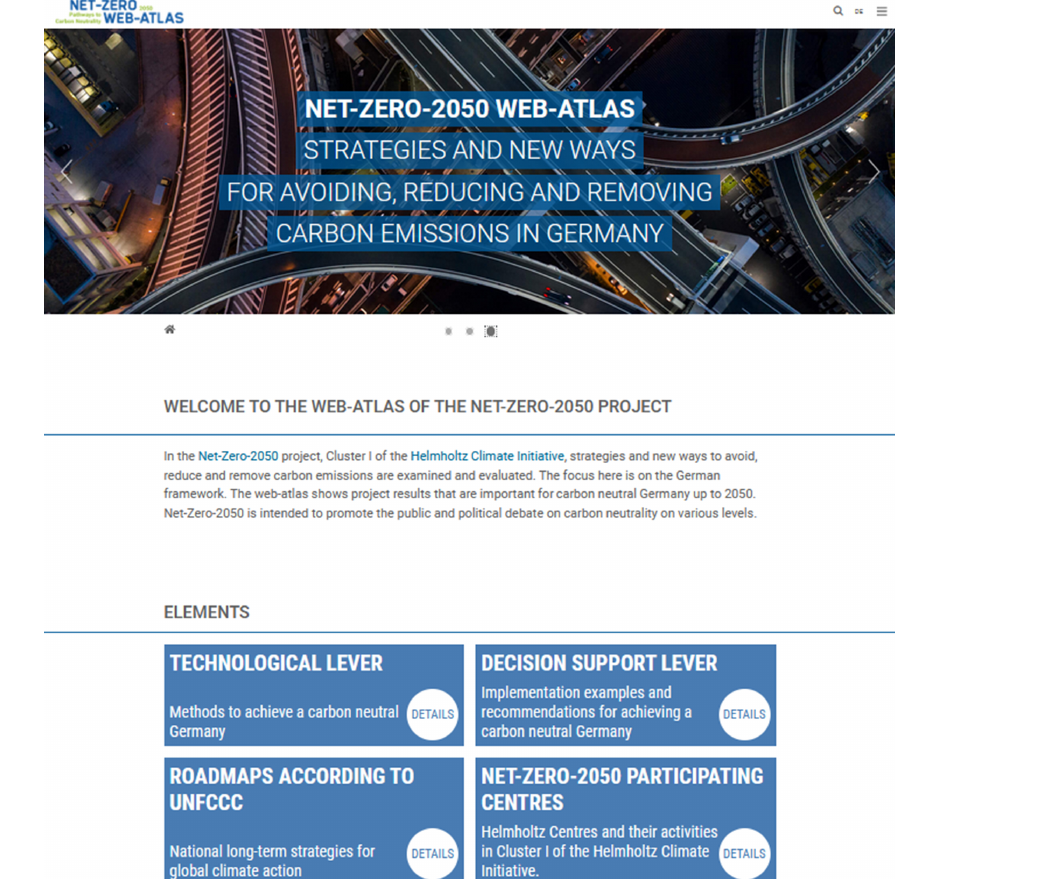
Figure 2. Net-Zero-2050 Web-Atlas landing page. Source: Screenshot of https://atlas.netto-null.org/ (last access: 3 June 2022).